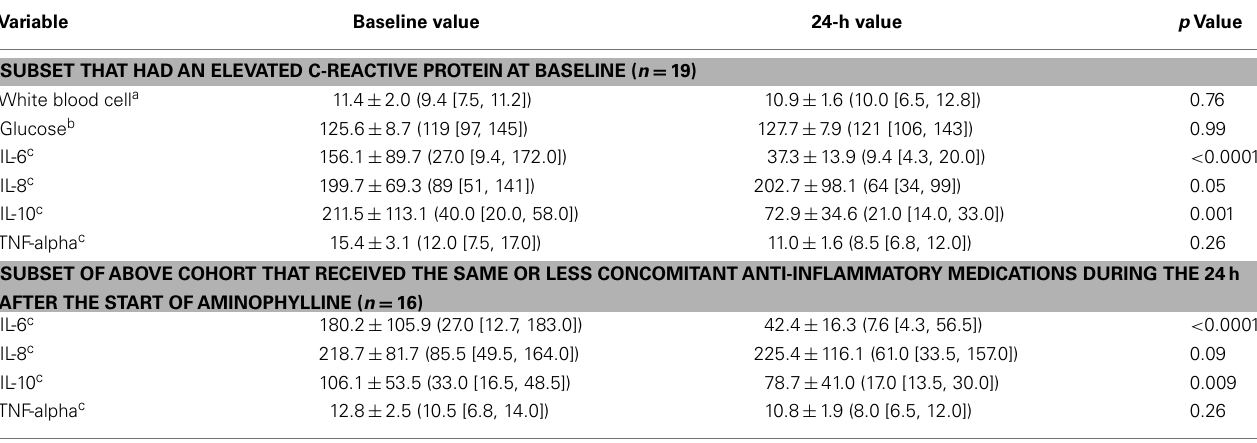
Table 3 |Assessment of inflammatory parameters before and after 24h of aminophylline .